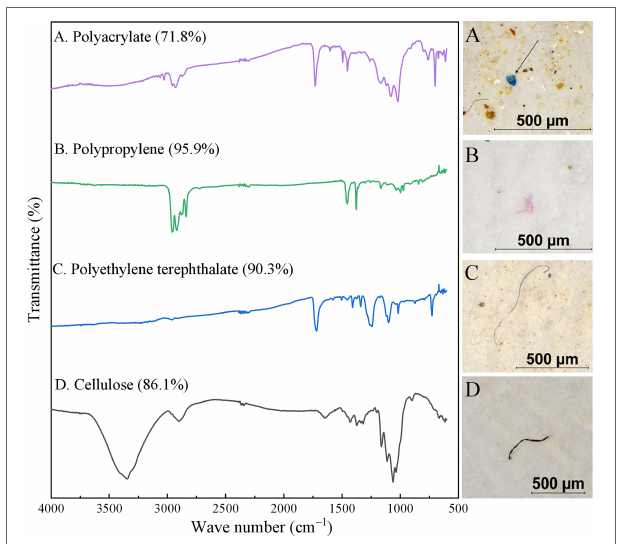
FIGURE 4 | Typical MPs for identification and their composition. (A) Blue fragment, (B) purple film, (C) fading fiber from blue to transparent, and (D) black fiber.